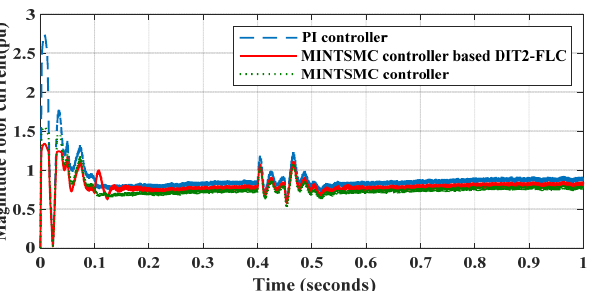
Figure 11. Magnitude rotor current of DFIG system under scenario I via the PI controller, MINTSMC controller, MINTSMC controller-based DIT2-FLC.